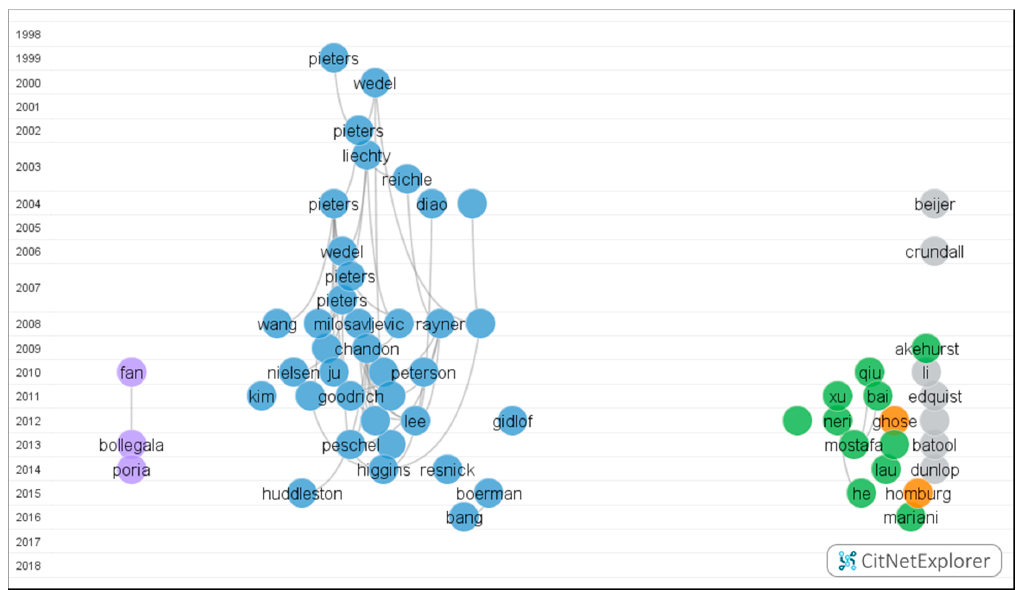
Figure 3. Citation network (1998–2018).